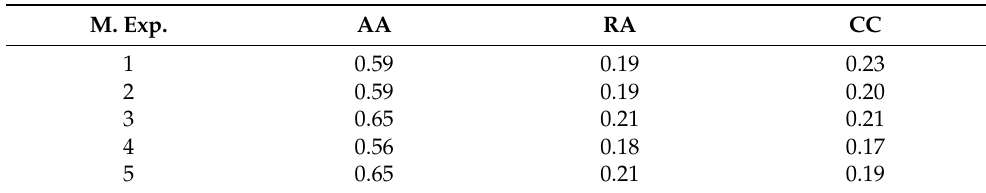
Table 8. Average agreement (AA), relative agreement (RA), and consensus coefficient (CC). Values of